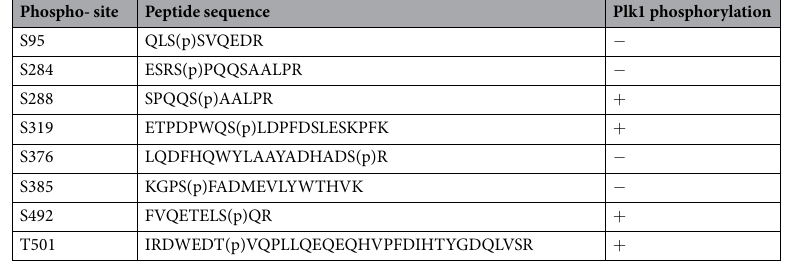
Table 1. Mass spectrometry analysis of CAP-H2 phosphorylation by Plk1 in vitro . All of identified phospho- peptides are shown. + means the phosphorylated site that is increased by